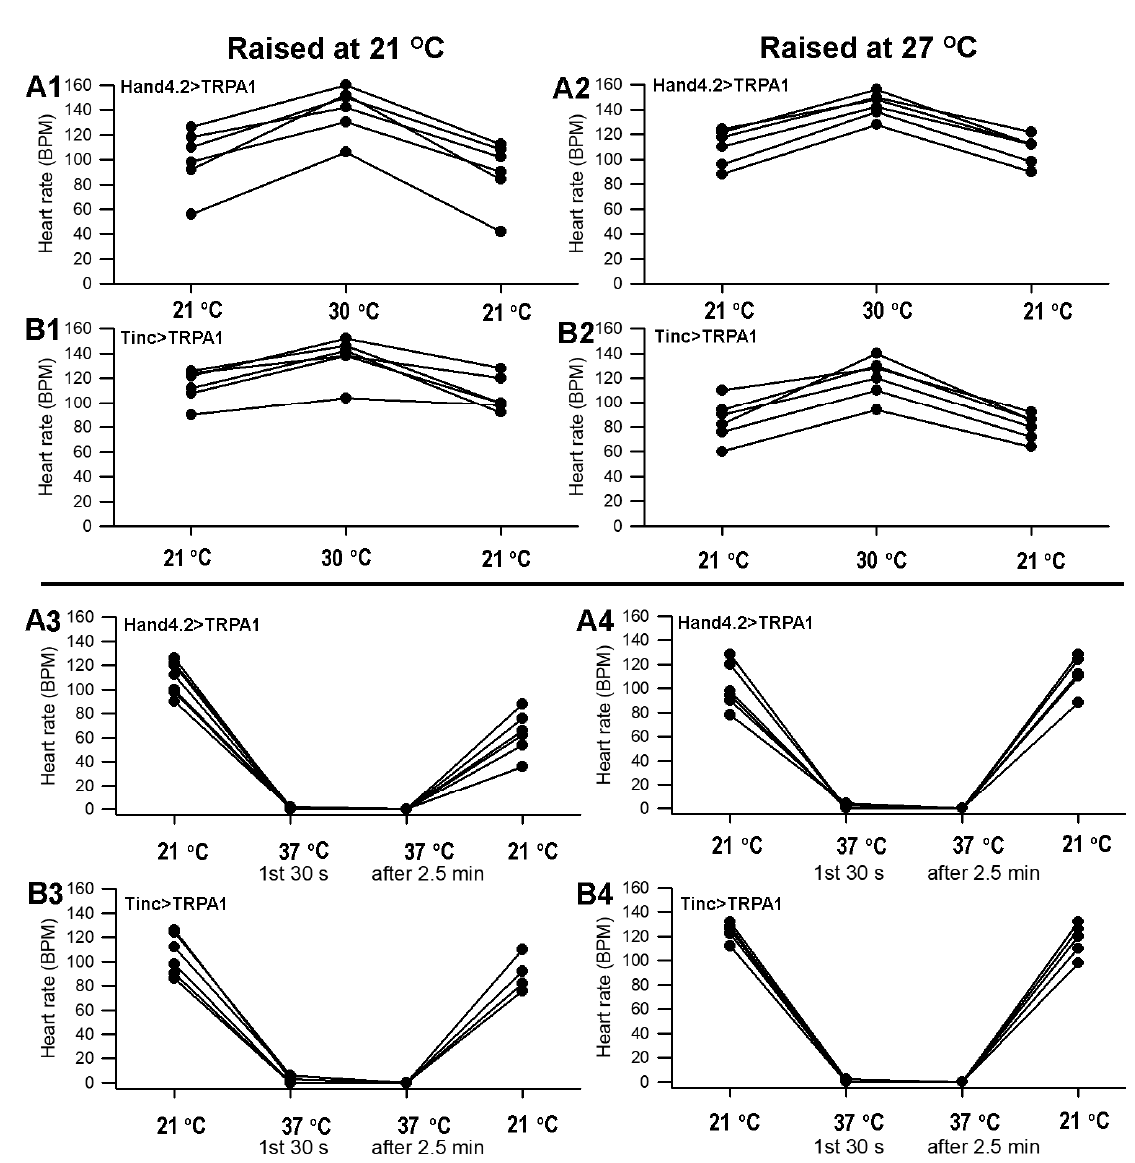
Figure 5. The heart rate for the dissected larvae over-expressing TrpA1 specifically in the heart. The heart rate increased in Hand4.2>TrpA1 ( A1 , A2 ) and Tinc>TrpA1 ( B1 , B2 ) from 21 to 30 ◦ C ( p < 0.05, paired t -test) for both conditions of larvae raised at 21 ◦ C ( A1 , B1 ) as well as at 27 ◦ C ( A2 , B2 ). The strains Hand4.2>TrpA1 ( A3 , A4 ) and Tinc>TrpA1 ( B3 , B4 ) upon exposure at 37 ◦ C all rapidly decreased heart rate and maintained a low rate for 2.5 min. Upon exposure to 21 ◦ C, the rates increased. The same trend was present for the larvae raised at 21 ◦ C ( A3 , B3 ) as well as at 27 ◦ C ( A4 , B4 ). Controls for these strains are illustrated in Figure 4 top panels under the same conditions.